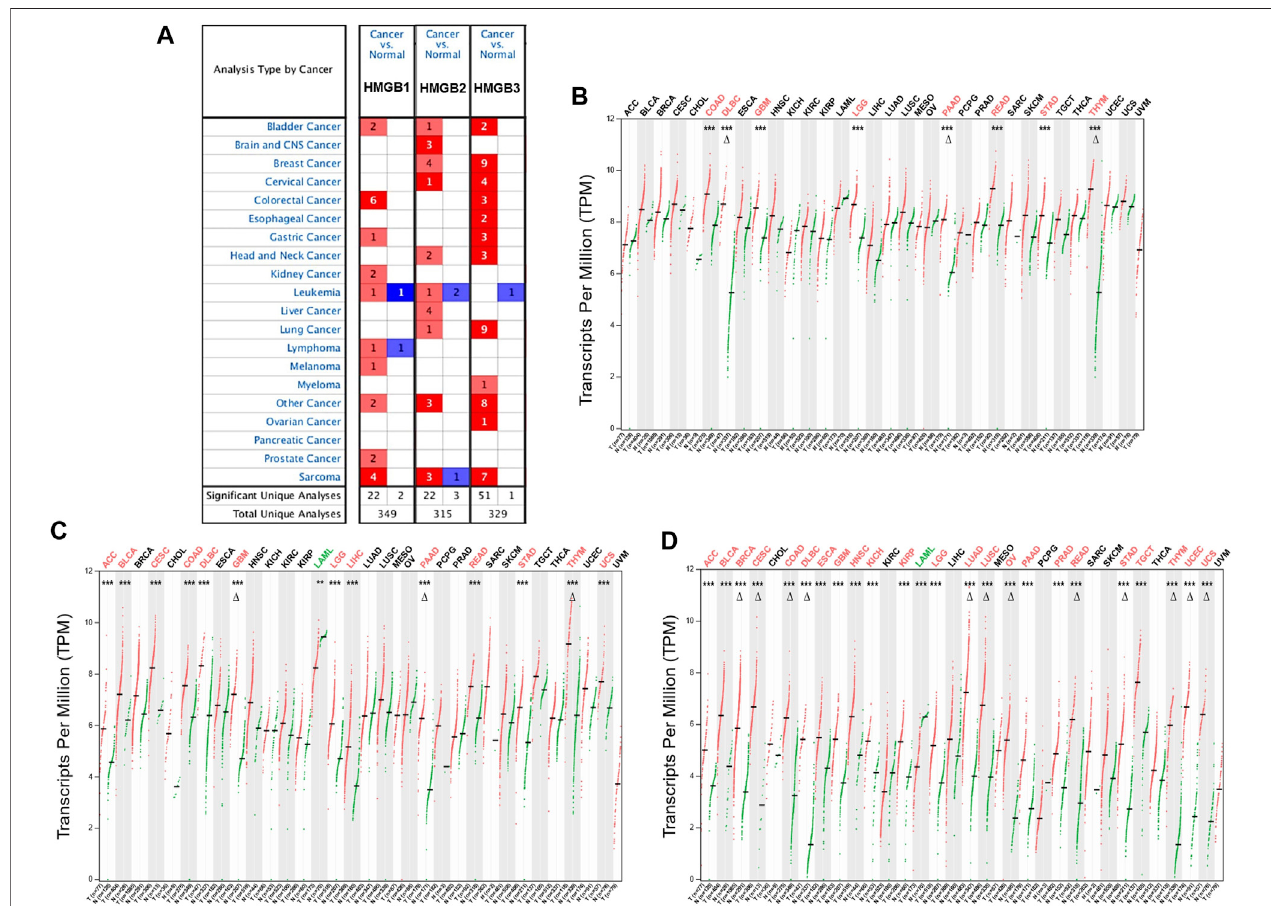
FIGURE1| ThedifferentialexpressionofHighMobilityGroupBox(HMGBs)betweencancersandnormalcontrols. (A) AsummaryofthedatasetsinwhichHMGBs weresigni fi cantlyup-(red)ordown-(blue)expressedincancers,comparedwithnormalcontrols(Oncomine).Numbersincellsrepresentdatasetcounts.Theexpression of (B) HMGB1, (C) HMGB2, and (D) HMGB3 in TCGA cancers and paired normal controls (GEPIA2). A black font indicates no signi fi cant difference; red or green fonts indicate signi fi cant up- or down-expression, respectively, with |fold change (FC)| > 2 and p values < 0.01. *** p < 0.001; Δ |FC| > 4 and p < 0.01.